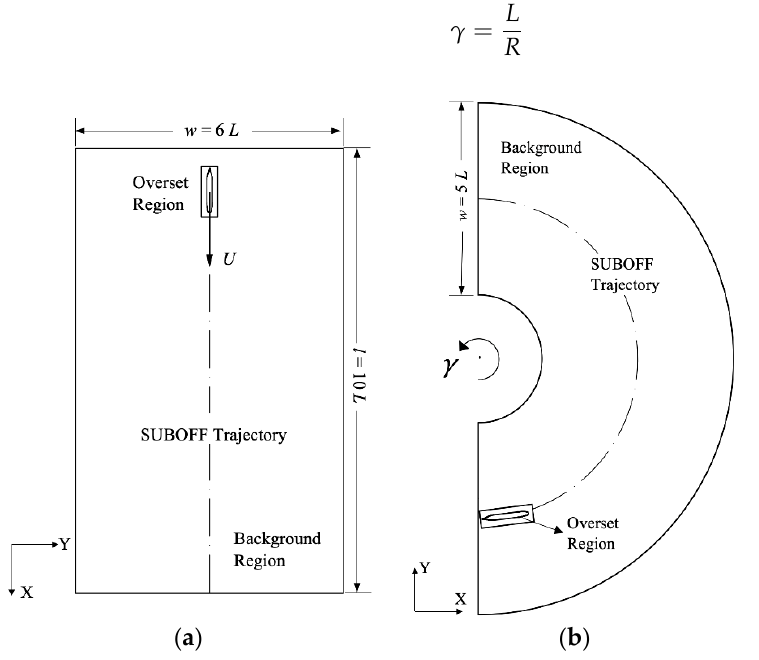
Figure 1. Schematic of the computational domain. ( a ) Straight navigation. ( b ) Steady turning mo-